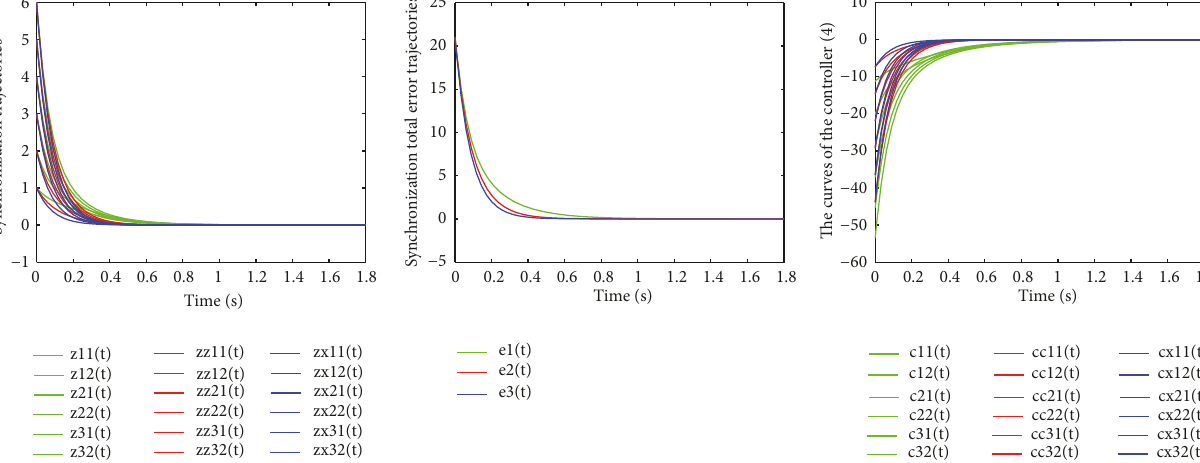
Figure 3: Synchronization trajectories, synchronization total error trajectories of network (1) with controller (4) and the curves of controller (4) for Case III of Example